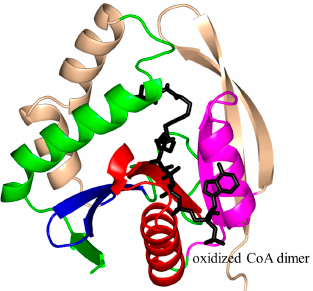
Figure 13. Cartoon representation of the structure of Bacillus subtilis PaiA in complex with an